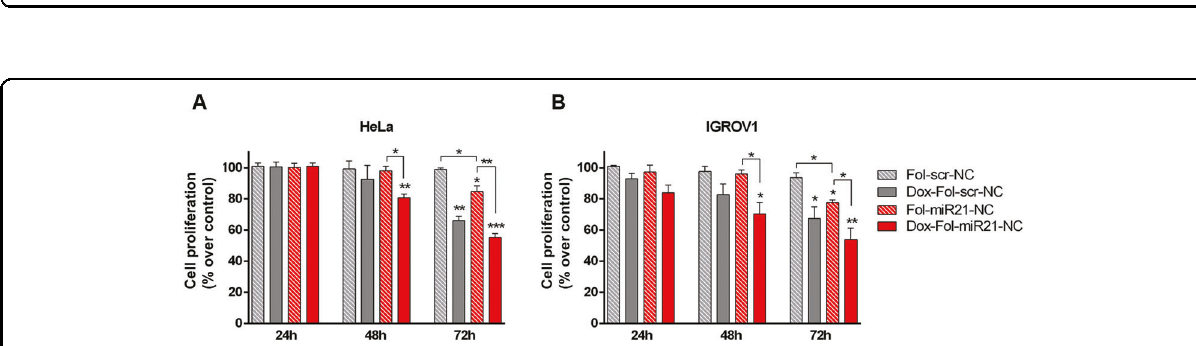
Fig. 7 Effect of Fol-miR21-NCs and Dox combined treatment. Cell proliferation of HeLa ( A ) and IGROV1 ( B ) evaluated by MTS assay. Cells were treated with Dox-loaded and not-loaded Fol-miR21-NCs and Fol-scr-NCs at different times, as indicated. The data represent mean ± S.E.M. of three separate experiments. The values are the mean of six replicates, normalized on cell proliferation of untreated cells. Statistical signi fi cance: * P < 0.05, ** P < 0.01, and *** P < 0.01 (Student ’ s t